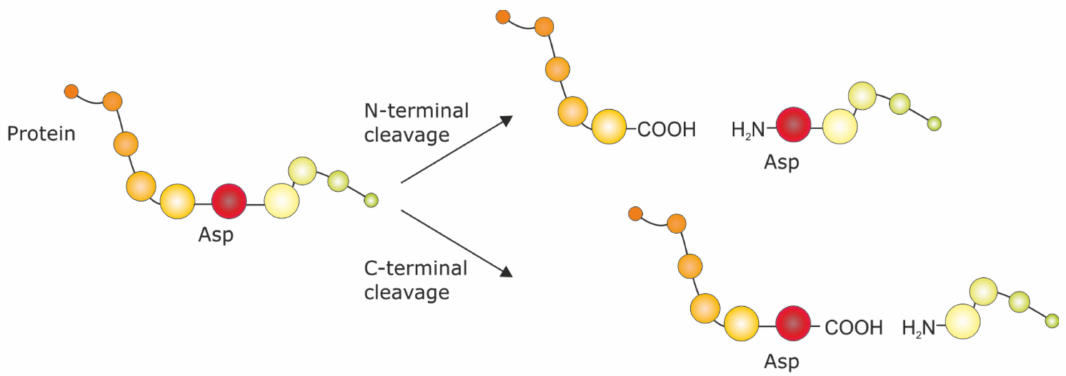
Figure 1. Chemical fragmentation by formic acid cleavage at the N-terminal or C-terminal Asp peptide bond